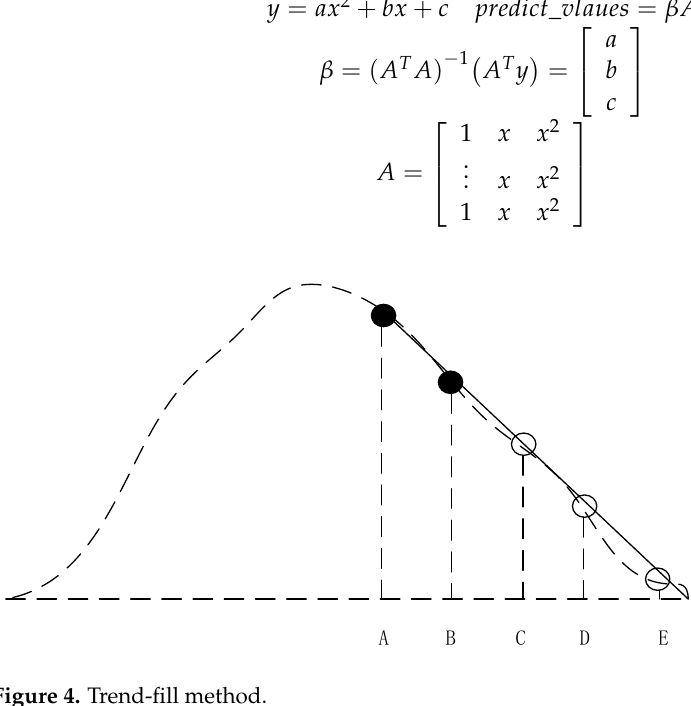
Figure 4. Trend ‐ fill method. Figure 4. Trend-fill